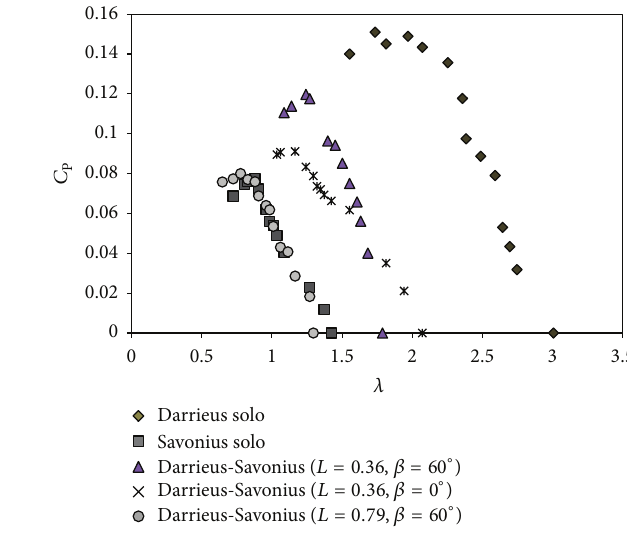
Figure 4: Coefficient of Torque.